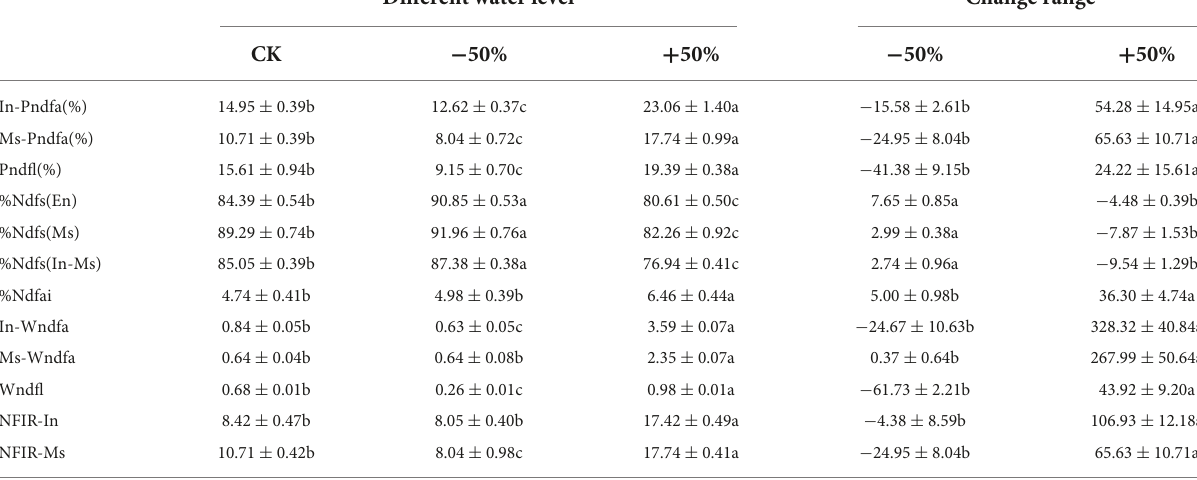
TABLE 2 Effect of water on nitrogen fixation and nitrogen transfer.